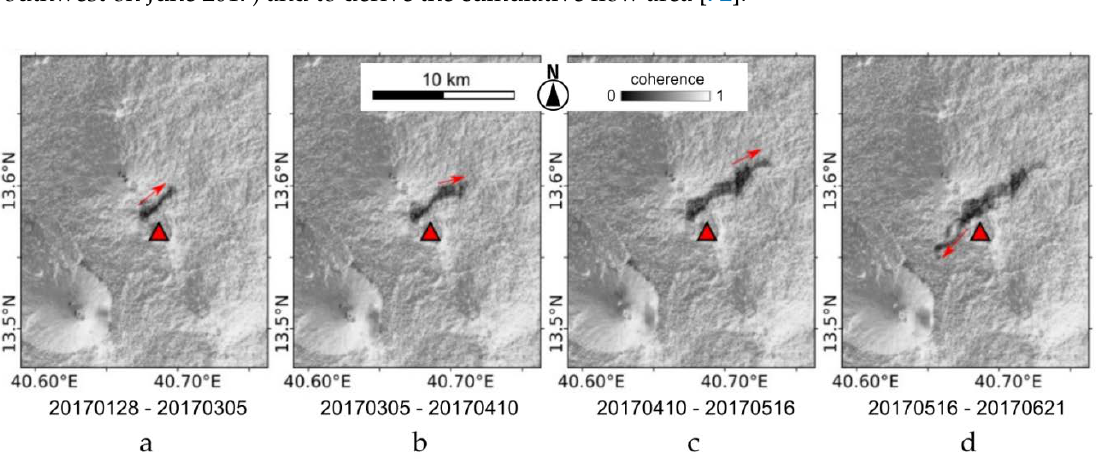
Figure 12. Descending wrapped interferograms generated by the LiCSAR system showing ground deformation associated with ( a ) the March 2017 intrusion at Cerro Azul and ( b ) the January 2017 intrusion at Erta Ale.